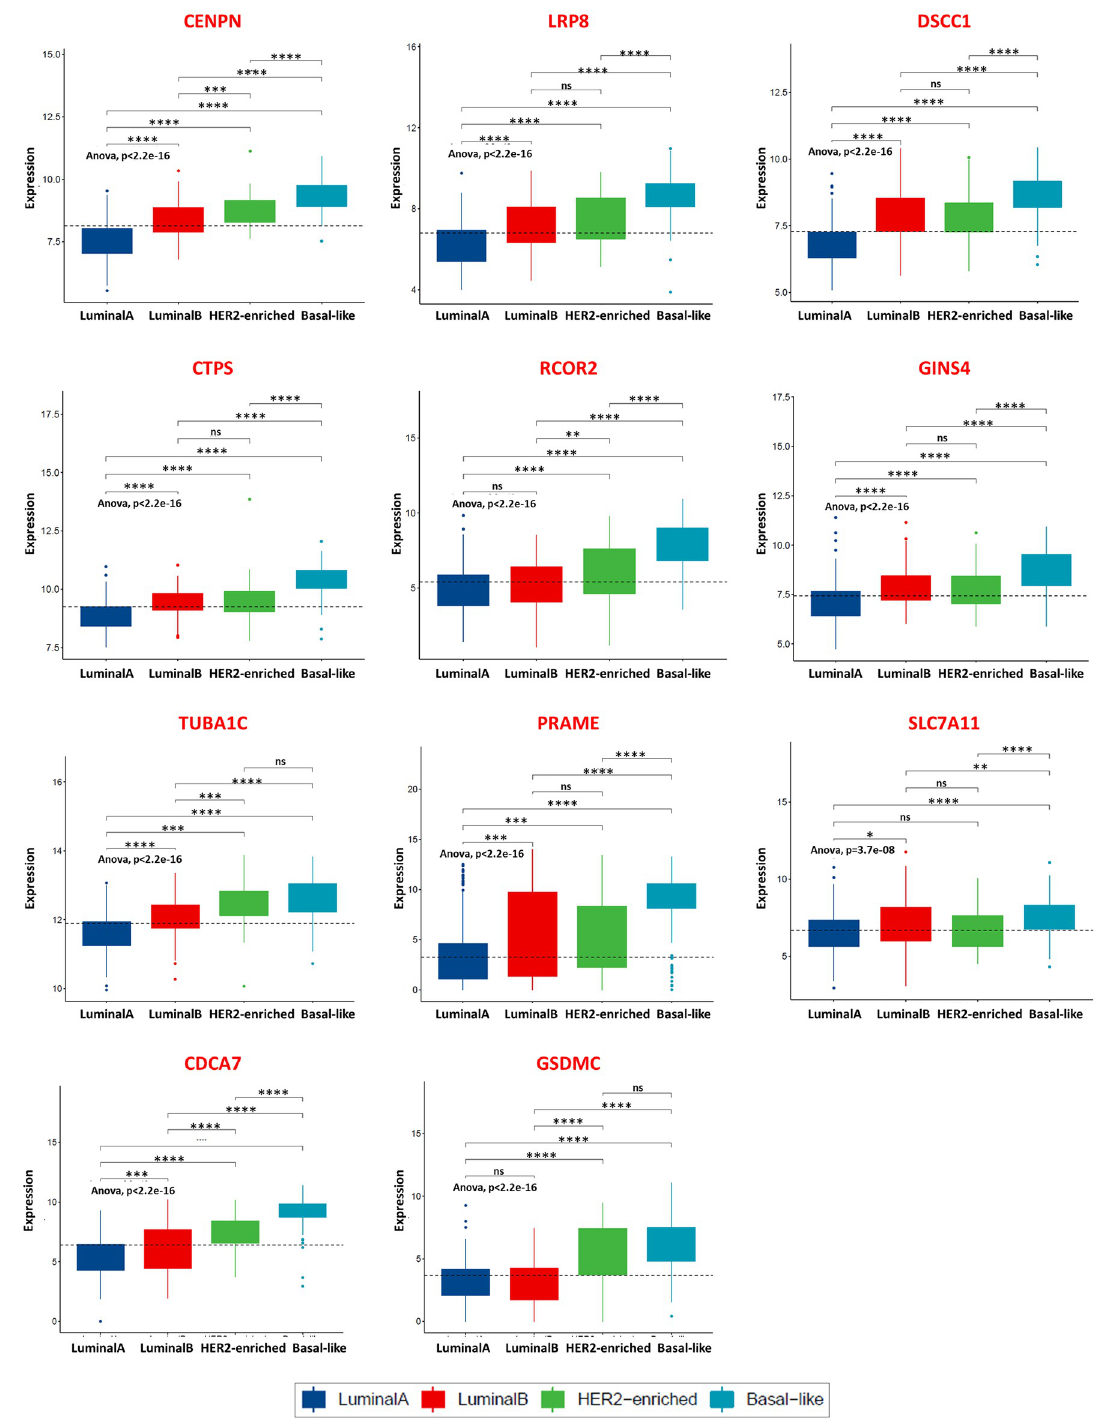
Fig 3. Expression of the switch genes with an unfavourable prognostic value across the PAM50 breast cancer subtypes. Gene expression levels of the 11 basal-like specific switch genes point out from the Kaplan-Meier survival analysis in TCGA breast invasive carcinoma patients affected by the four BC subtypes of PAM50 classification. The black dashed line reported in each plot indicates the median value used in the Kaplan-Meier survival analysis to split the low-expression and high-expression group. One-way ANOVA test was used to compare the means of the selected genes among the patients’ groups. T-test was used to perform multiple pairwise- comparisons and statistical significance was indicated by the star symbols (i.e., ns: p > 0.05, � : p � 0.05, �� : p � 0.01, ��� : p � 0.001, ���� : p �